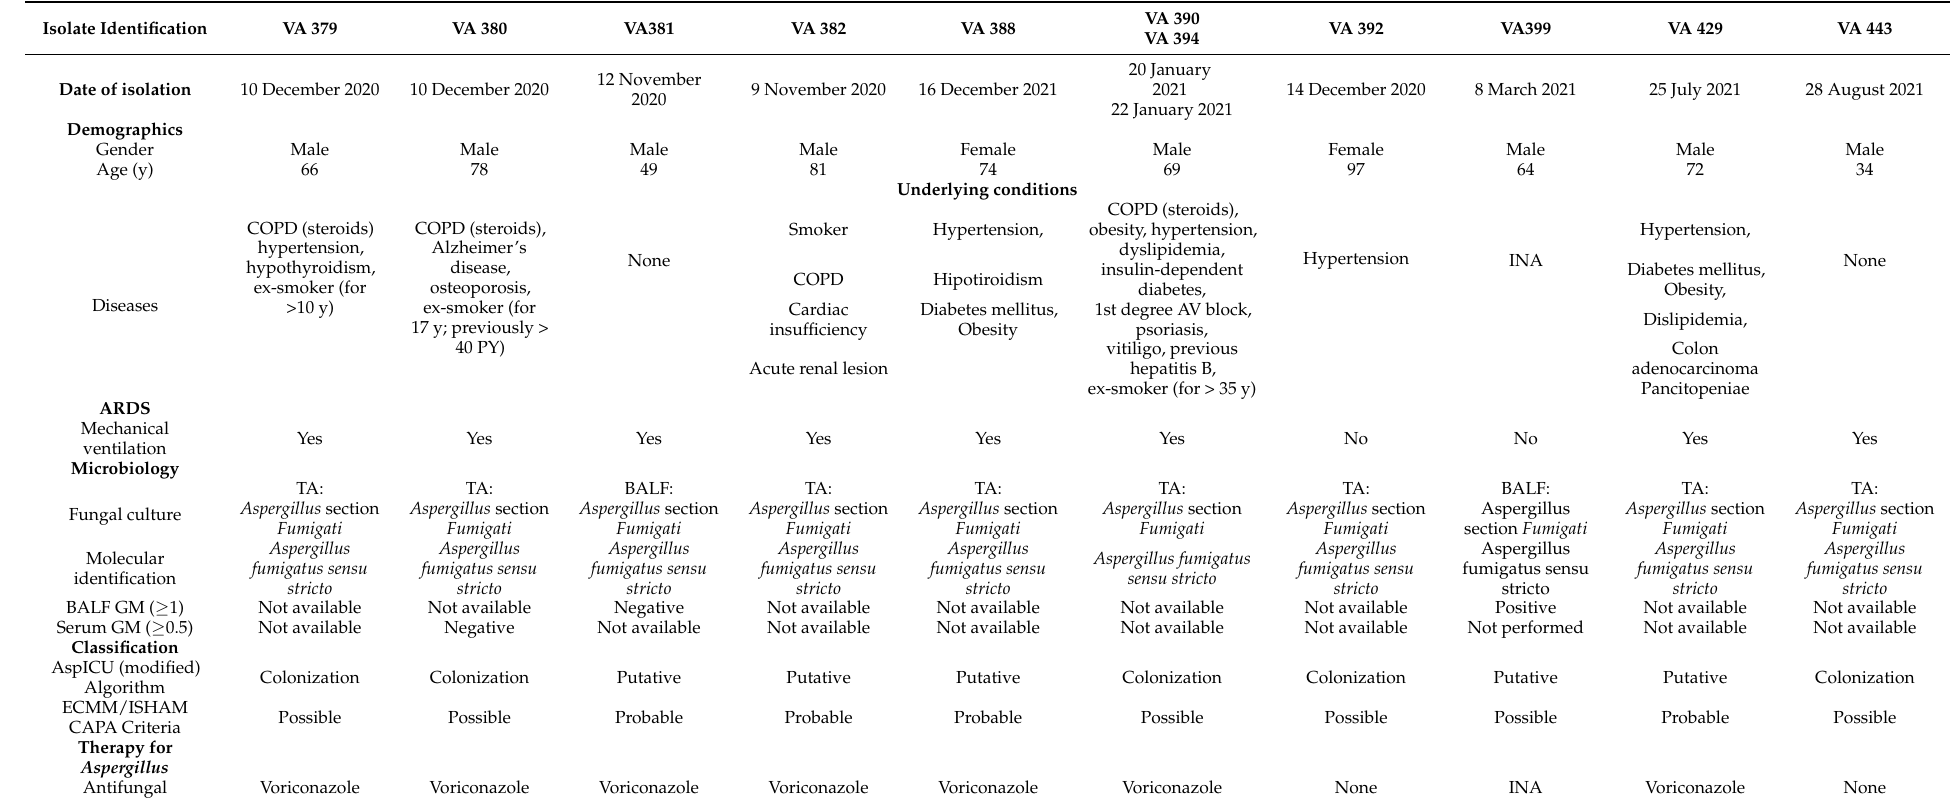
Table 1. Characterization of the isolates collected from COVID-19